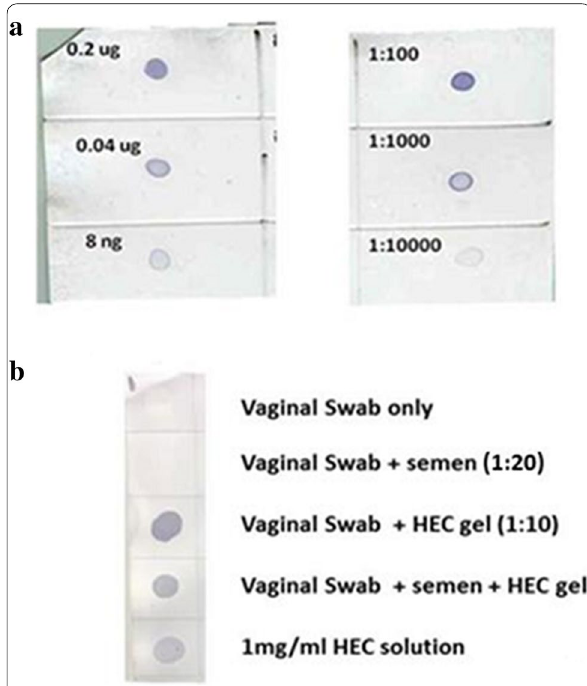
Fig. 3 Validation of the CBM-29-1-2 probe in detecting hydroxyethylcellulose (HEC) in placebo vaginal gel. a Positive detection of various amounts of pure, dissolved HEC powder by the probe confirming the feasibility of the detection protocol (left). Positive detection of HEC in various dilutions of placebo vaginal gel (right). b Positive detection of HEC in vaginal swab extracts containing HEC gel semen. Extracts from vaginal swabs only or ± vaginal swabs containing semen are negative confirming